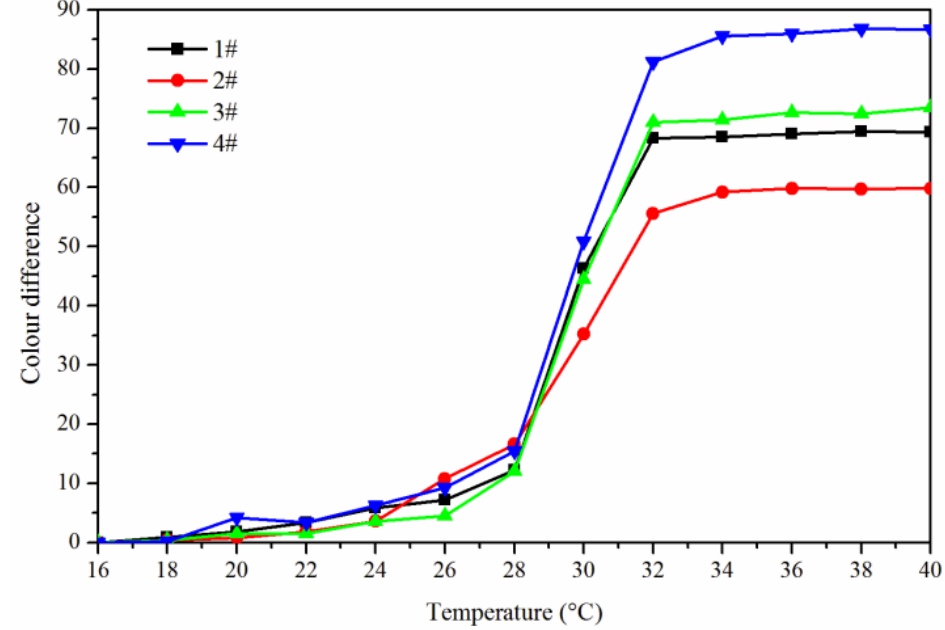
Figure 4. The effect of temperature (16 °C to 40 °C) on the color difference of the coating film.